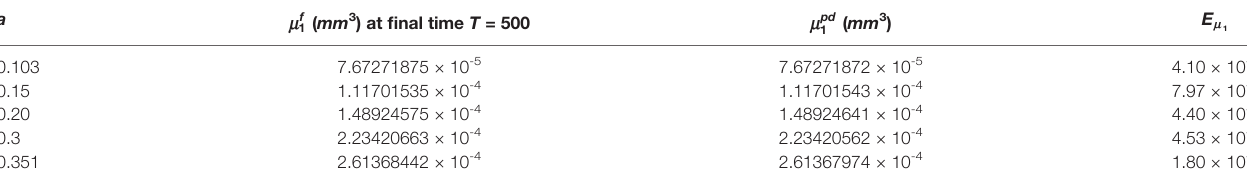
TABLE 3 | Comparison of the large time tumor mass and the predicted tumor mass for several values of a .